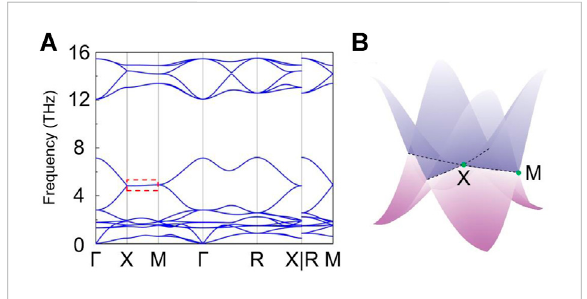
FIGURE 2 (A) Phonon dispersion of Ag 2 O along the Γ -X-M- Γ -R-X|R-M paths. (B) The 3D plot of the cross-shaped nodal